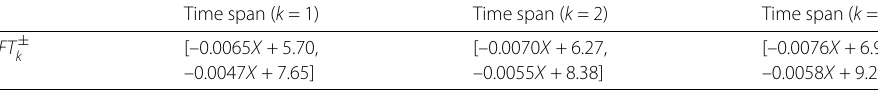
Table 4 Transportation cost from the incinerator to the landfill (in dollars)